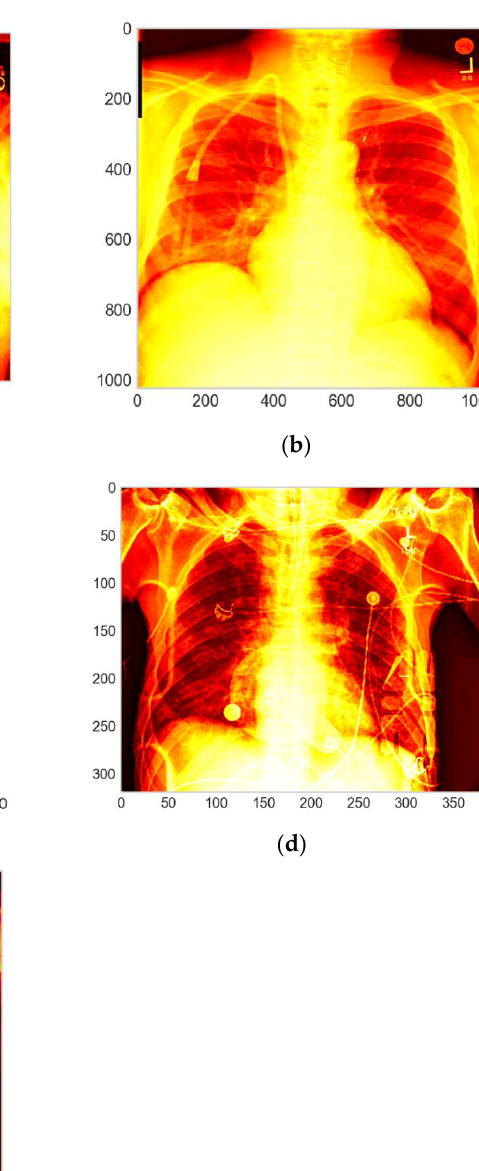
Figure 5. Learning curves of the training process and the learning rate-decreasing curve.